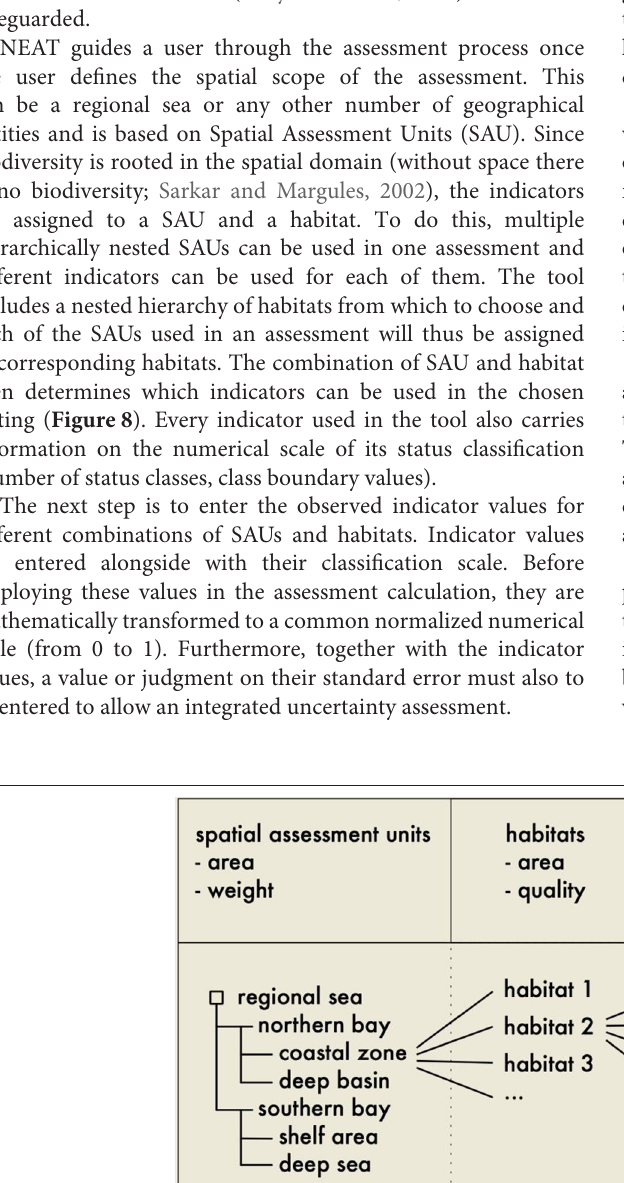
Frontiers in Marine Science |